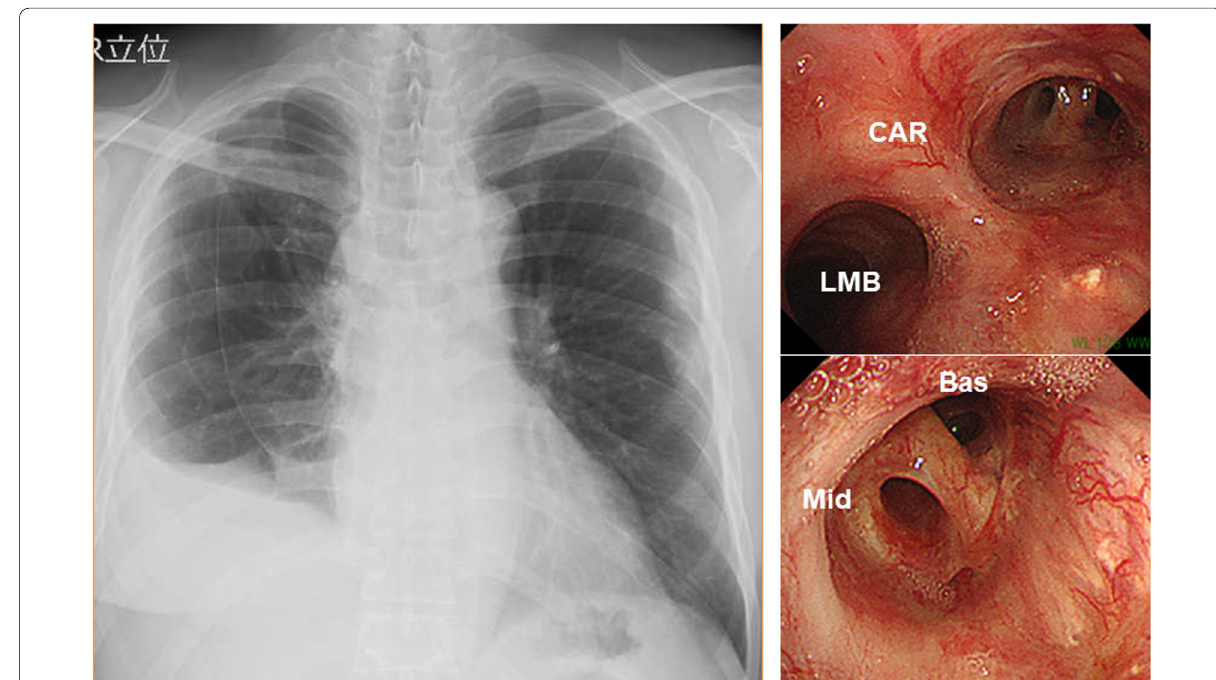
Fig. 5 Chest roentgenogram (left) and bronchoscopy (right) at 4 months after surgery showed excellent lung expansion and bronchial healing. CAR carina, LMB left main bronchus, Mid right middle bronchus, Bas right basal